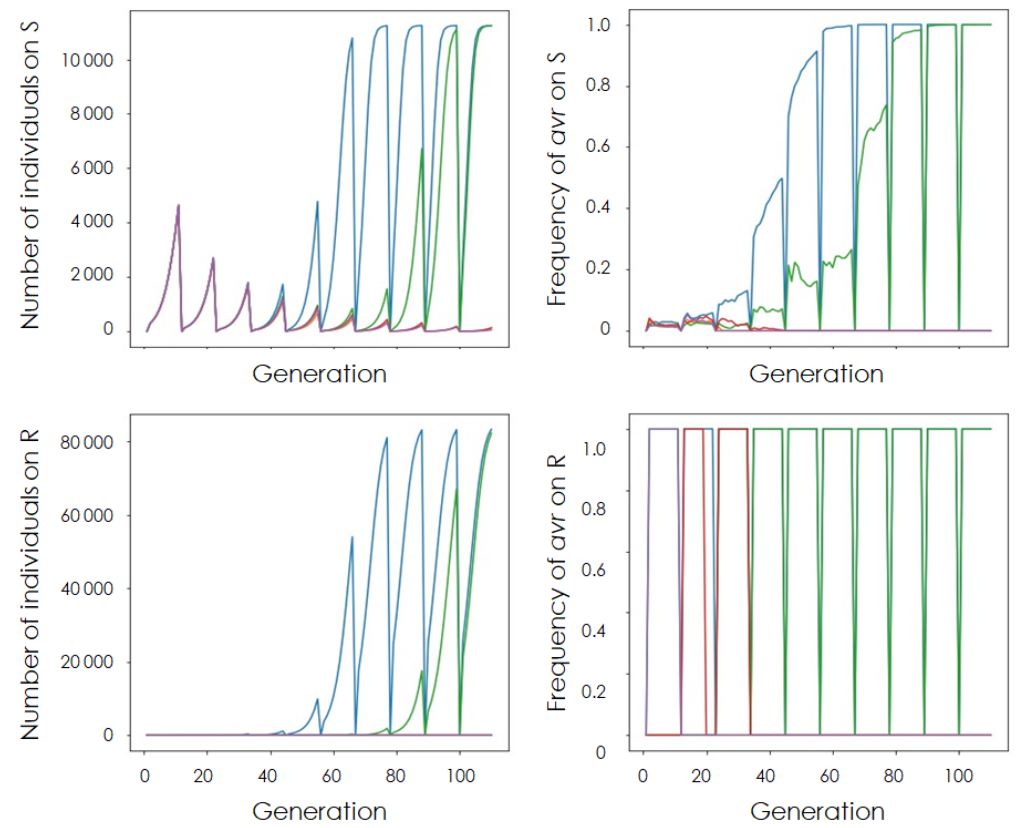
Figure S2 – Example of the simulated populations demographic (on the left) and virulent allele frequency (on the right) dynamics through time on S and R compartments. The model was run for four replicates with diploid individuals and host alternation, propR = 0.9 , r = 1.5 , f avr = 0.025 , and mig = 0.05 . Each color represents a distinct